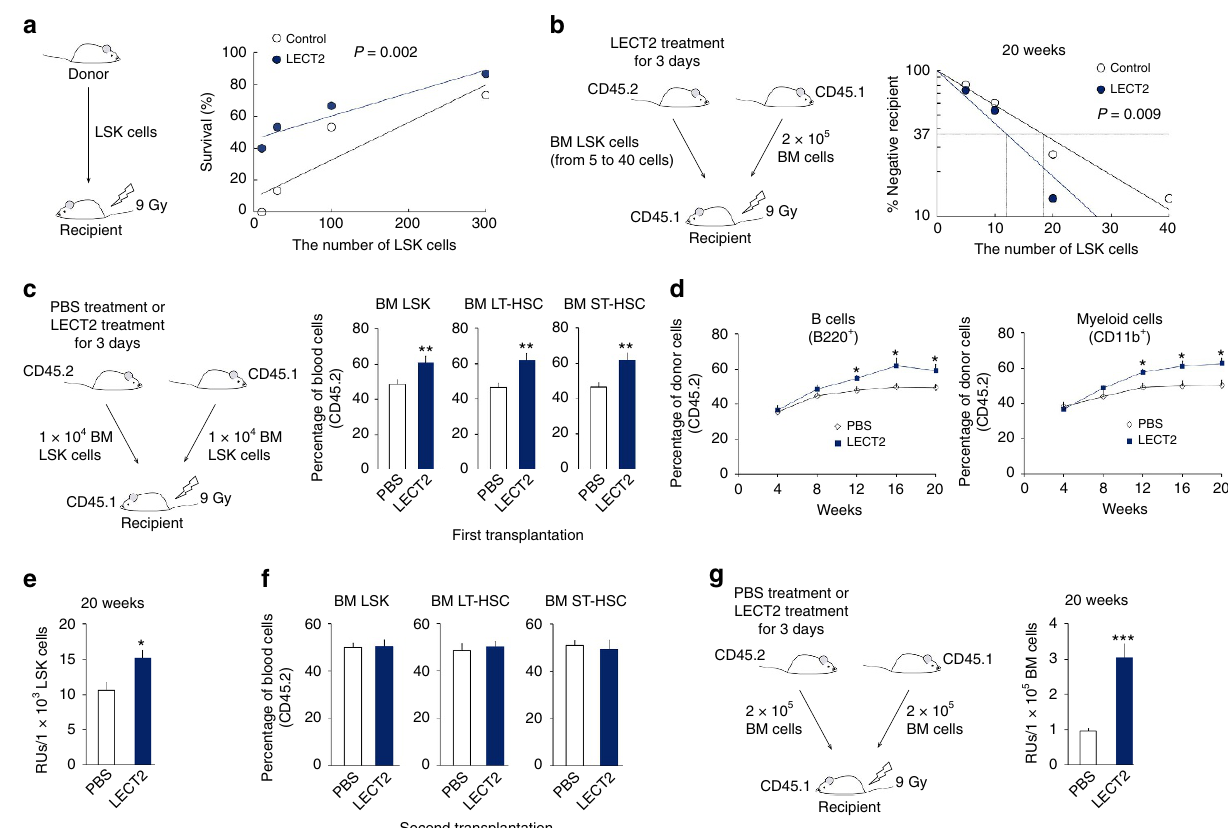
Figure 2 | LECT2 increases the transplantation potential of BM LSK cells. ( a ) The survival rate was analysed following transplantation with LSK cells from the BM of 3-day LECT2 treated mice; n ¼ 15 each point. ( b ) Competitive repopulation unit (CRU) content within each group of mice competitively transplanted with LSK cells at each dose; n ¼ 15 each point. Horizontal dashed line, 37% of recipient mice failed to engraft. Vertical dashed lines, various CRU frequencies for each treatment. ( c ) The percentages of donor LSK cells, LT-HSCs, and ST-HSCs in BM at 20 weeks after first competitive transplantation with PBS- or LECT2-treated mice are shown; n ¼ 5. ( d ) The percentages of B cells (B220 þ ) and myeloid cells (CD11b þ ) in the peripheral blood of the chimaeric mice competitively transplanted with LSK cells; n ¼ 6. ( e ) Repopulating units based on donor chimaerism determined by flow cytometry in peripheral blood 20 weeks after competitive transplantation with LSK cells; n ¼ 6. ( f ) The percentages of donor LSK cells, LT-HSCs, and ST-HSCs at 20 weeks after second competitive transplantation with LSK cells. n ¼ 5. ( g ) Repopulating units (RU) based on donor chimaerism determined by flow cytometry in peripheral blood 20 weeks after competitive transplantation with BM cells of 3-day LECT2 treated mice; n ¼ 5. The data represent means ± s.e.m. The data are representative of two independent experiments. * P o 0.05, ** P o 0.01, *** P o 0.001 using Poisson’s statistic ( a , b ) and one-way ANOVA ( c – g